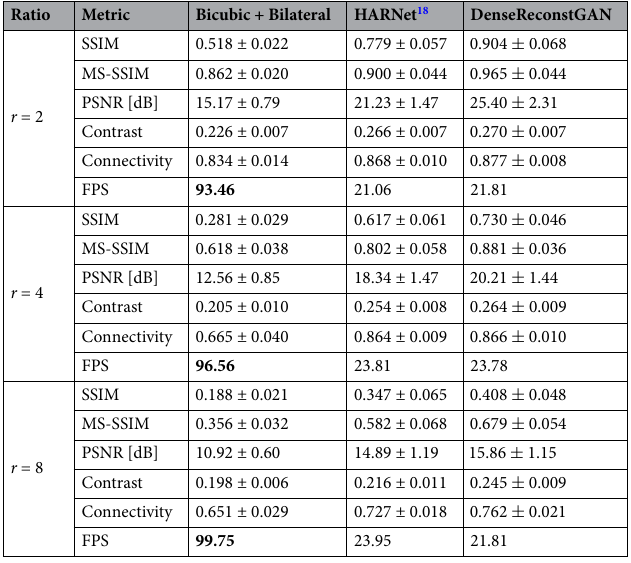
Table 3. Performance metrics of our DenseReconstGAN, HARNet, and the bicubic interpolation method with bilateral filtering evaluated on the test dataset composed of maximum intensity projection (MIP) enface angiograms from various biosamples. SSIM structural similarity index measure, MS-SSIM multiscale structural similarity index measure, PSNR peak signal-to-noise ratio, FPS frames per second. Significance values are given in